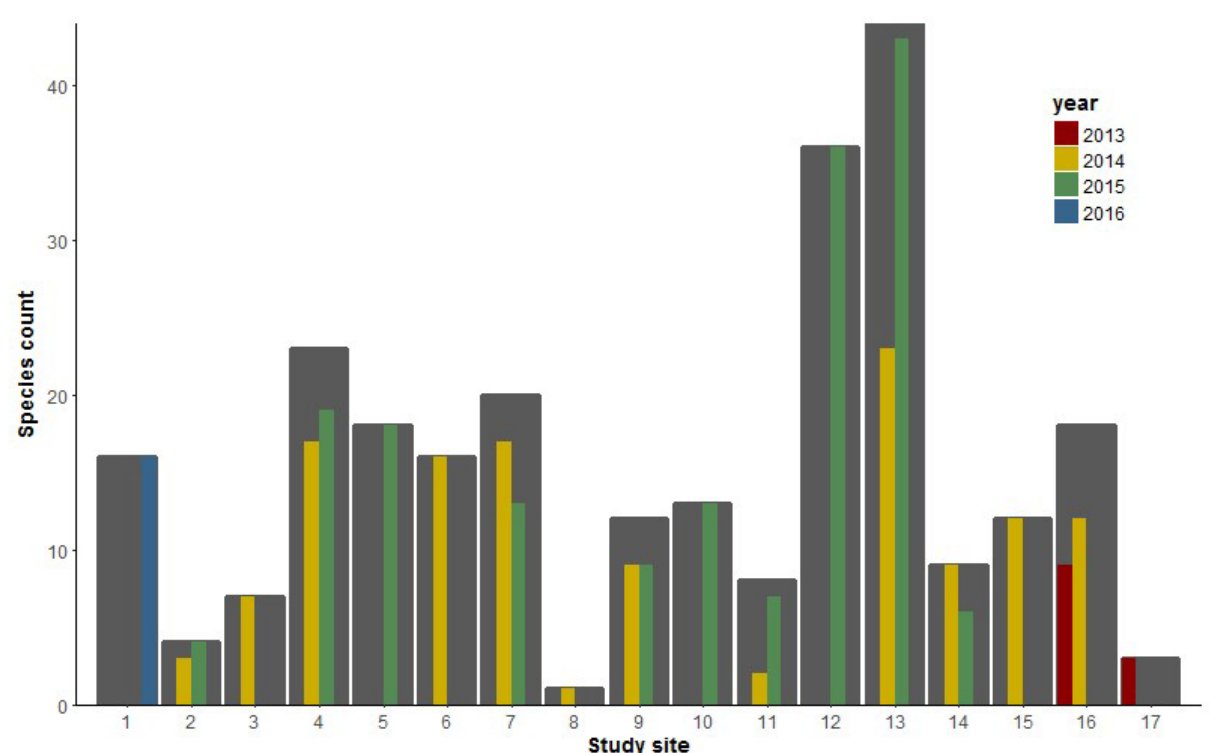
Figure 7. Total number of species collected in each study site (grey bars) and by sampling year (coloured bars). Study site codes correspond with those in the map of Figure 1.